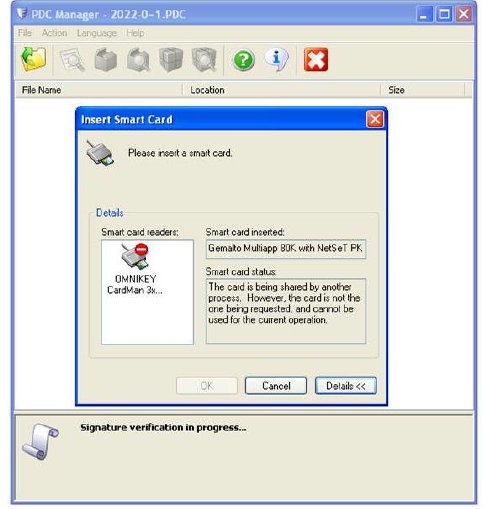
Figure 8. An attempt to maliciously access the contents of a protected file.